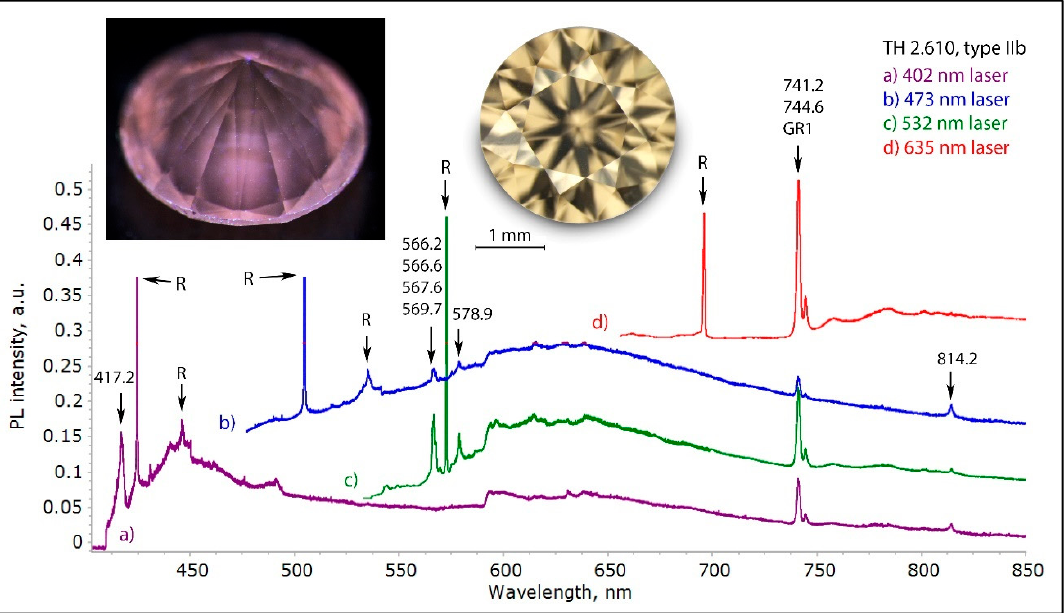
Figure 27. The photoluminescence spectra of a rare type IIb brown diamond, recorded using four different lasers. With many of the features being characteristic of low nitrogen Ia or type II diamonds, the asymmetric and somewhat large band at 417.2 nm is only rarely found in type IIa diamonds but is very common in type IIb diamonds. The spectra were shifted vertically for clarity.